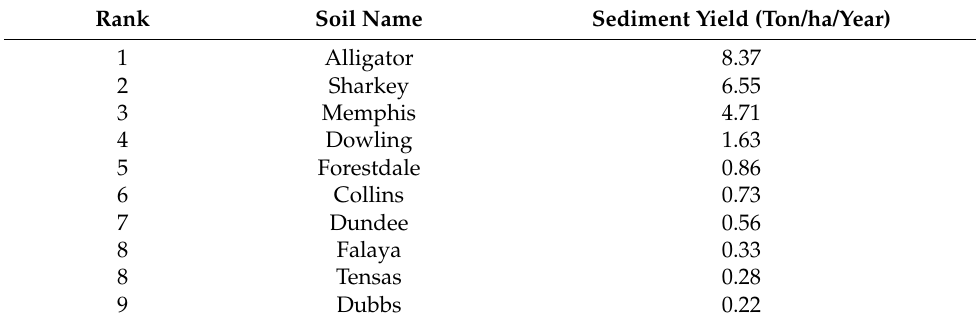
Table 6. Major soils with major agricultural land use.